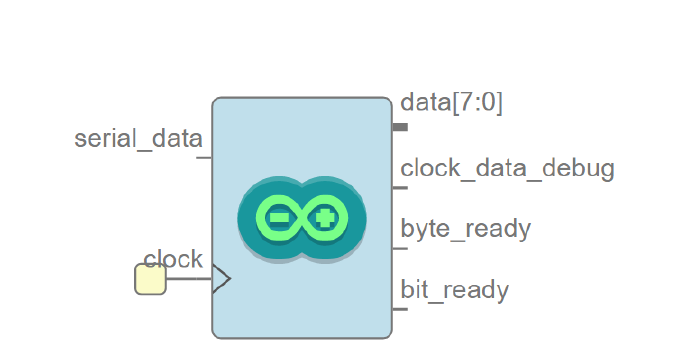
Figure 6. Appearance of Arduino Nano module in IceStudio.